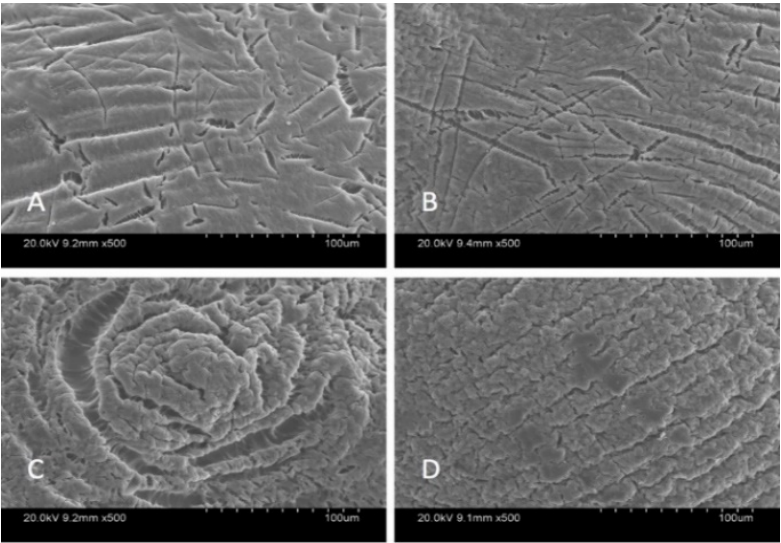
Figure 1. SEM images of beads at 500× magnification: Ca-Alg2 ( A ), Ca-Alg2/GO5 ( B ), Ca-Alg2/GO10 ( C ), Ca-Alg2/GO20 ( D ).